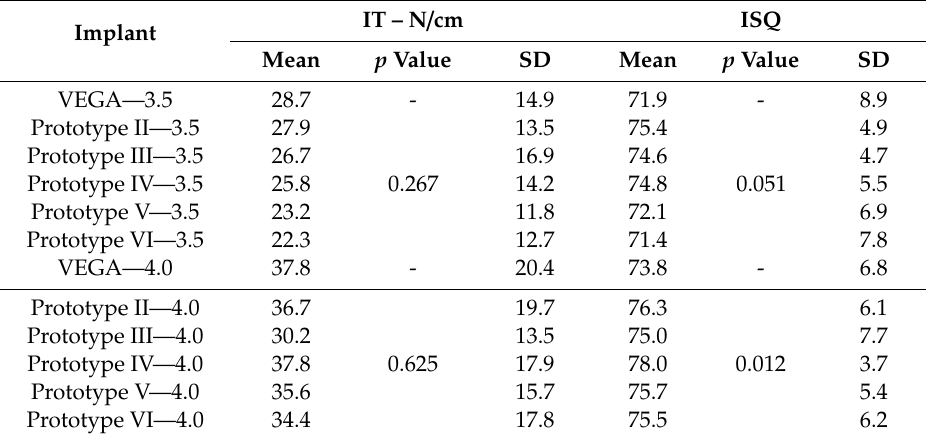
Table 2. Values of the IT and ISQ from the 2nd group—control and Prototypes II, III, IV, V, and VI with 3.5 and 4.0 mm diameters; the yellow values are the statistically significant